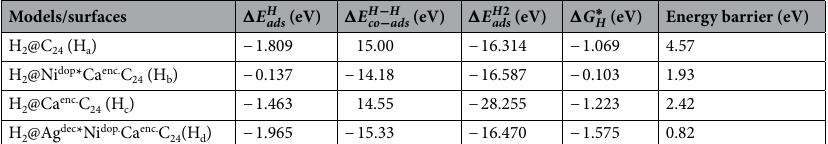
Table 4. Calculated atomic, molecular adsorption energies, co-adsorption energies ( (cid:31) E H − H (eV) , (cid:31) E co − ads ), free adsorption energies, and Energy barrier for the formation of H 2 by photocatalytic reaction mechanism on the different studied surfaces. Unit of conversion (1 Hartree = 27.211 eV); dop = doped, enc. = encapsulated, dec. = decorated.